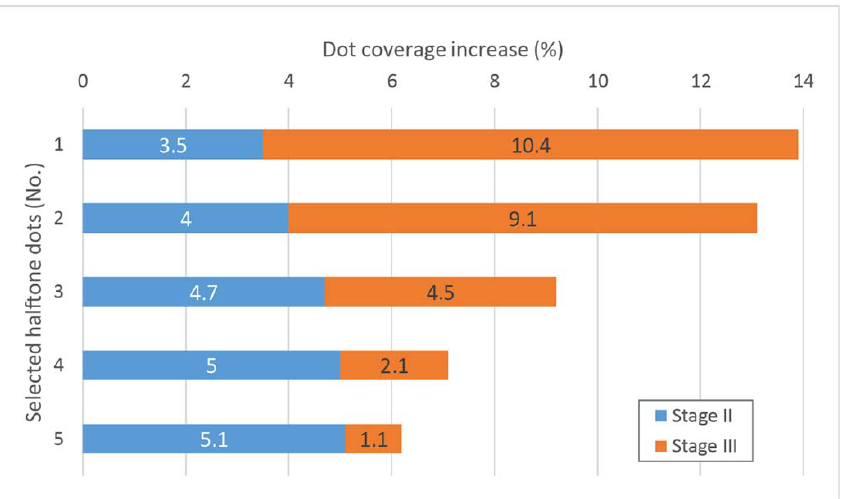
Figure 4. Dot coverage values of five selected halftone dots at three stages of printing.